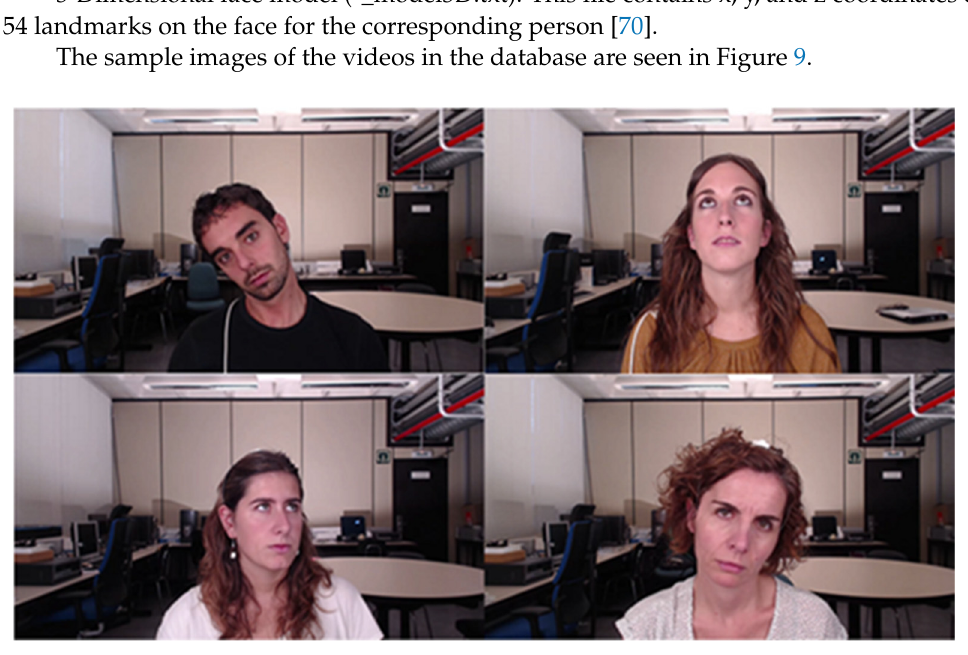
Figure 9. Sample images taken from the UPNA Head Pose Database.